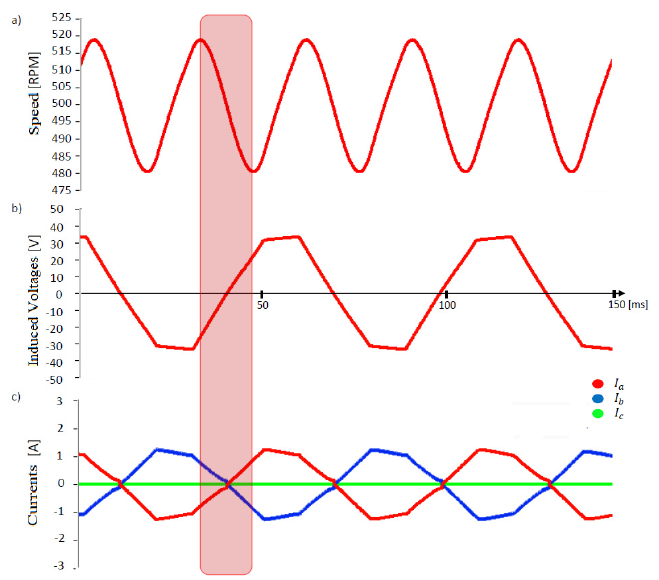
Figure 8. Numerical simulation of a BLDC motor under fault in phase c in 180° Six-Step operation mode with reduction current strategy: ( a ) speed; ( b ) induction voltage E ab ; ( c ) phase currents I a , I b and I c .